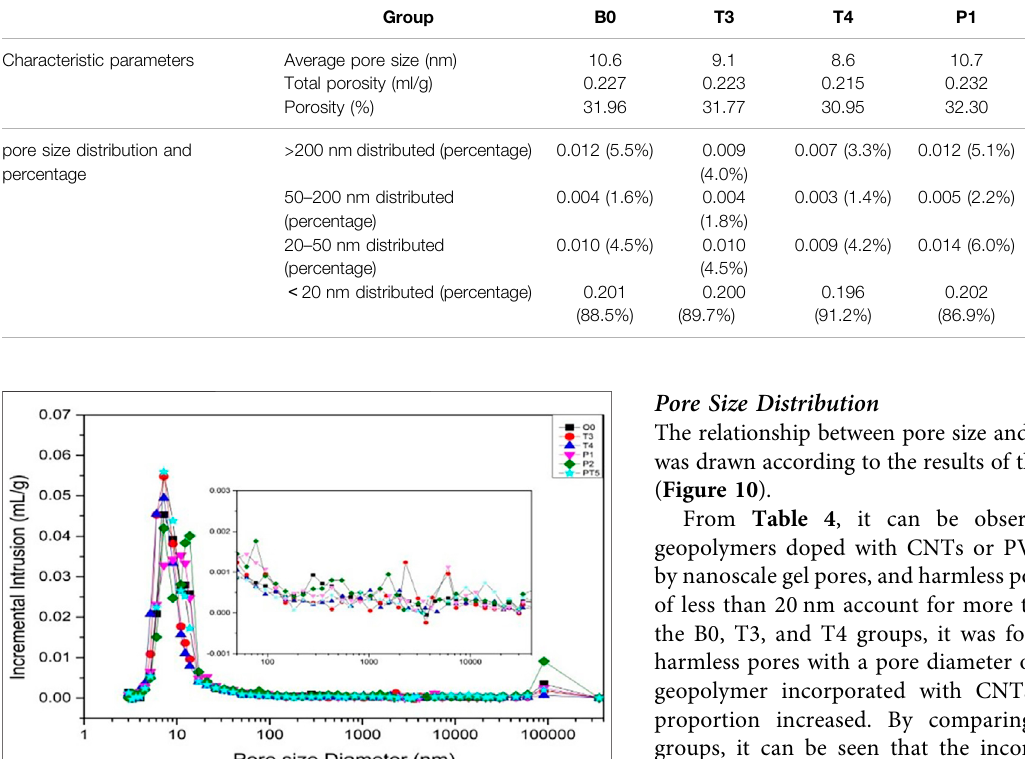
Frontiers in Materials |